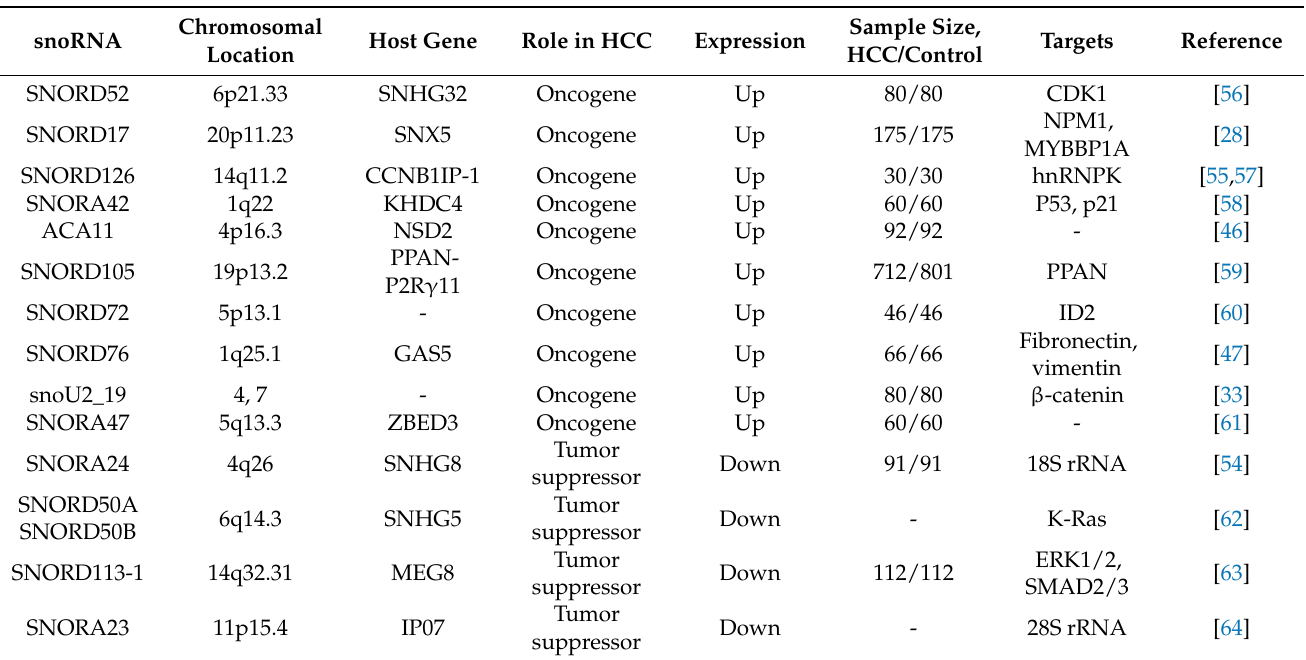
Table 1. HCC-related